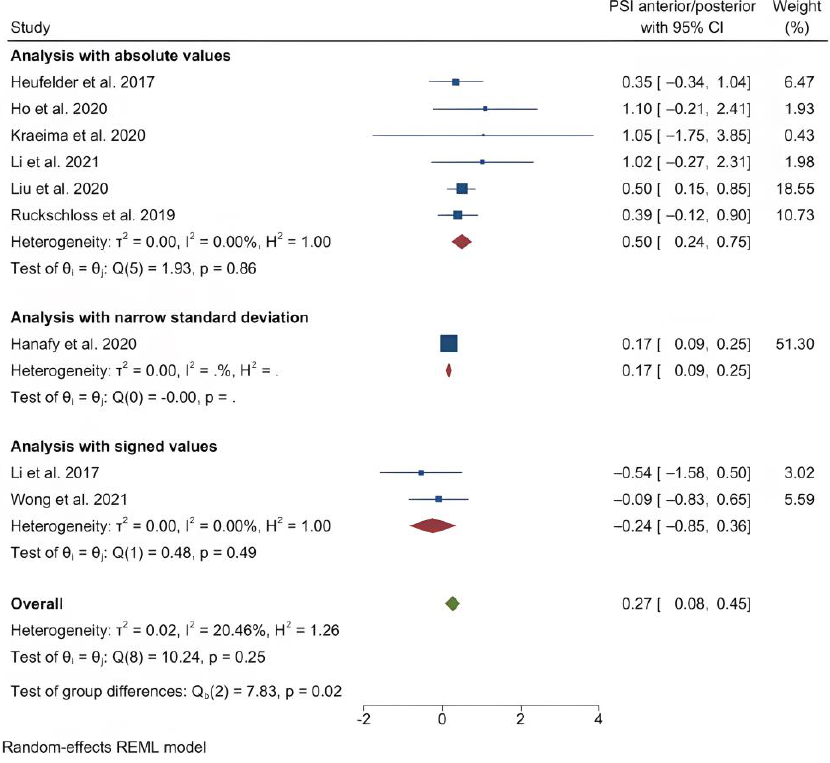
Figure 4. Forest plot showing mean antero-posterior deviation.